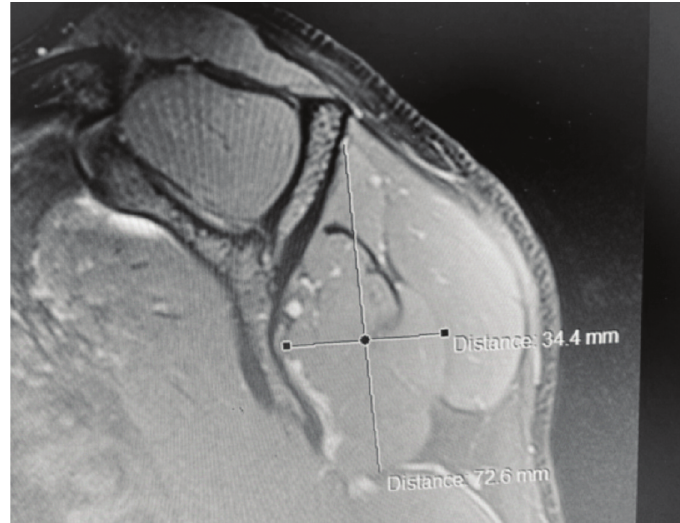
MRI showing complete resolution of the cyst and recovery of infraspinatus muscle Fig. 3: